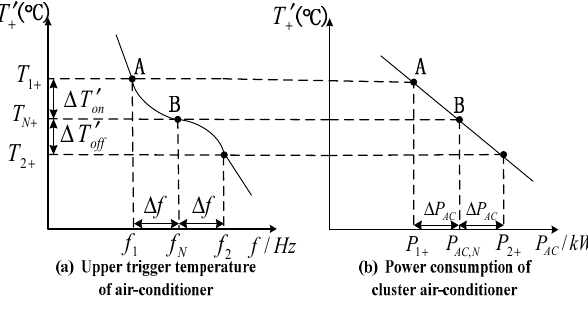
Figure 6. Frequency response characteristics of the cluster air conditioner.